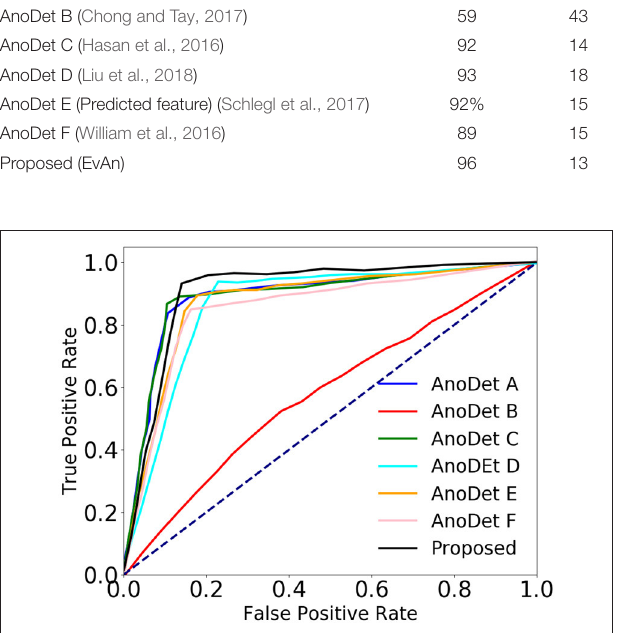
FIGURE 9 | Comparison of the proposed anomaly network with state-of-the-art frame-based anomaly networks in terms of ROC.